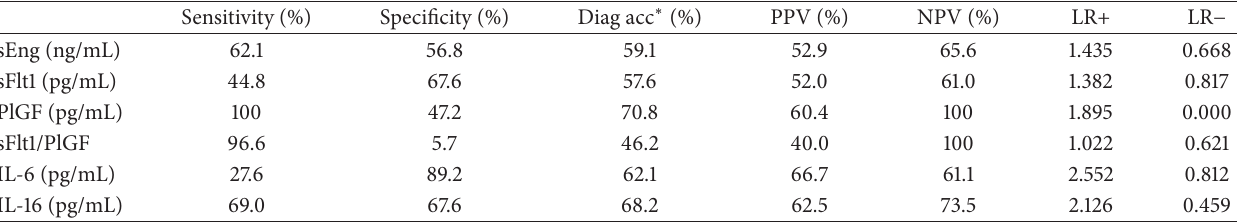
Table 4: Predictive characteristics of studied markers in relation to their